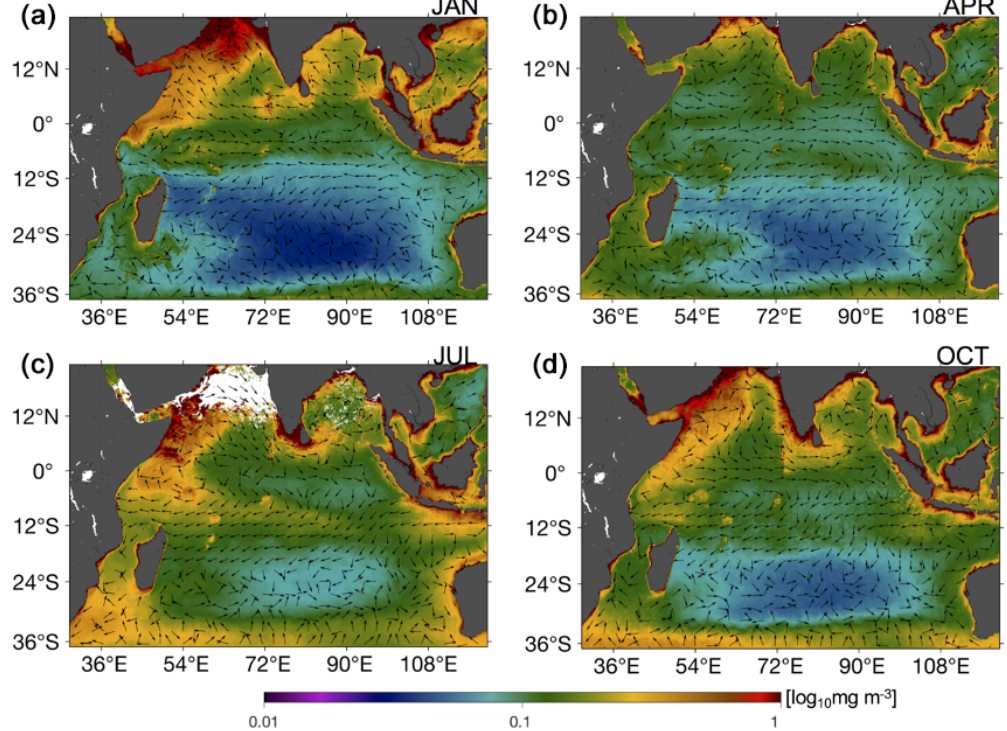
Figure 5. Climatology (2002–2018) of chlorophyll a concentrations (colour map) and current velocities (arrows) for (a) January, (b) April, (c) July, and (d) October. Chlorophyll a climatology was obtained from the MODIS-Aqua product, and current velocities were obtained from the third-degree Ocean Surface Current Analysis Real-time (OSCAR) product.